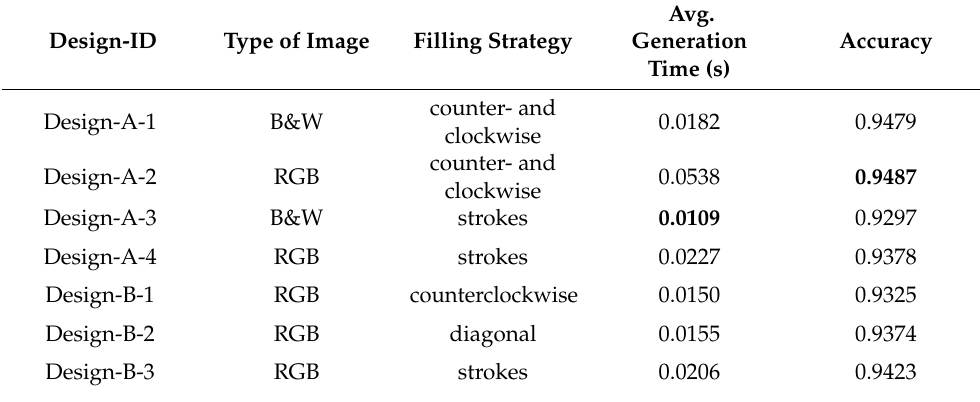
Table 1. Experiment-1.1 results—design performance comparison.